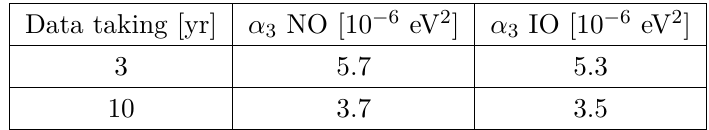
Table 4. 90% CL Upper limits for the decay constant, α 3 , for 3 and 10 years of data taking for both neutrino mass ordering hypotheses.